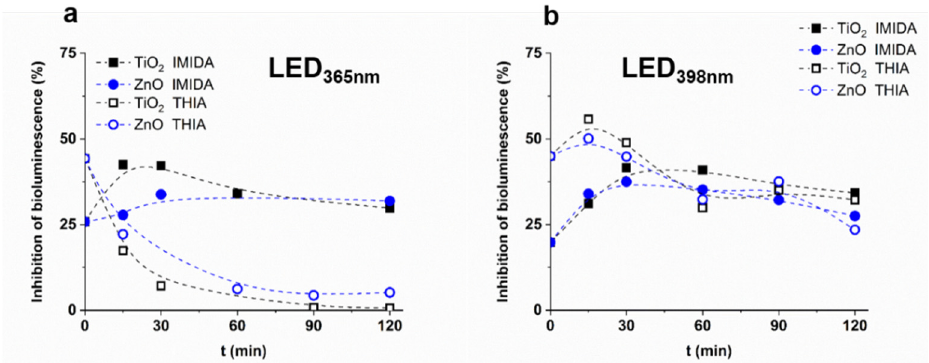
Figure 9. The ecotoxicity of IMIDA and THIA suspensions as a function of treatment time (( a ): LED 365nm , ( b ): LED 398nm ). (( a ): LED 365nm , ( b ): LED 398nm